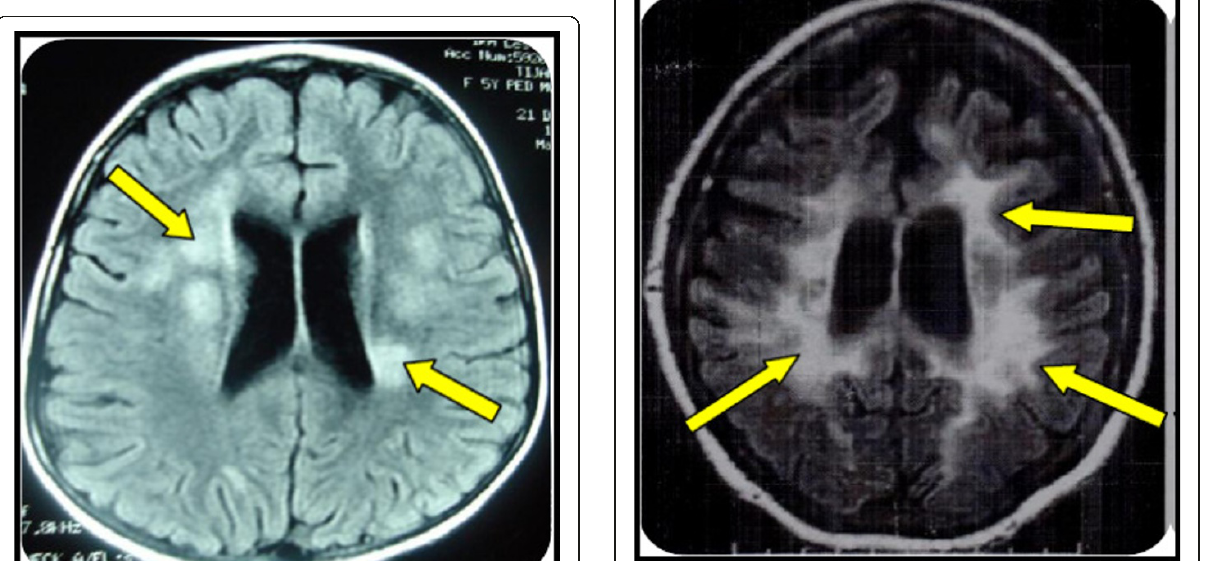
Figure 4 Brain MRI of the patient with adult form of MLD ‘ arrows ’ indicate the lesions of the white matter